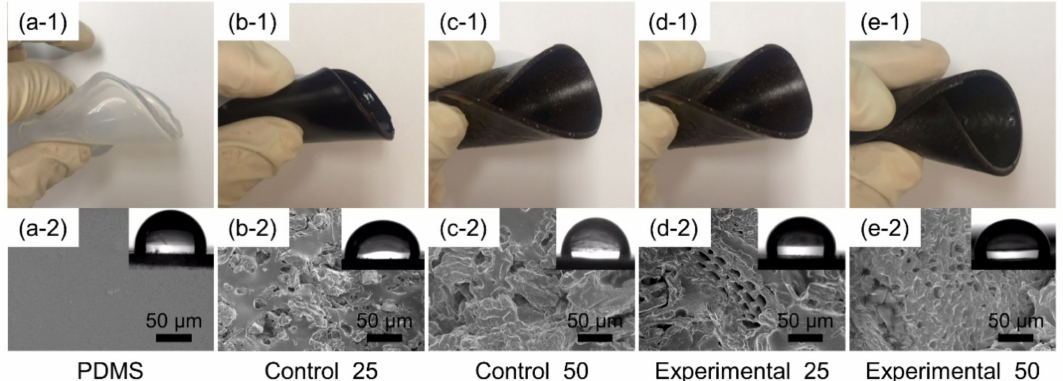
Figure 2. Photographs (upper section denoted by 1) of the rolling state of the bioelastomers. Field emission scanning electron microscopy (FE-SEM) images (lower section denoted by 2) of bioelastomer surfaces. Inset shows the water contact angle of the bioelastomers. (a: PDMS, b: Control_25, c: Control_50, d: Experimental_25, and e: